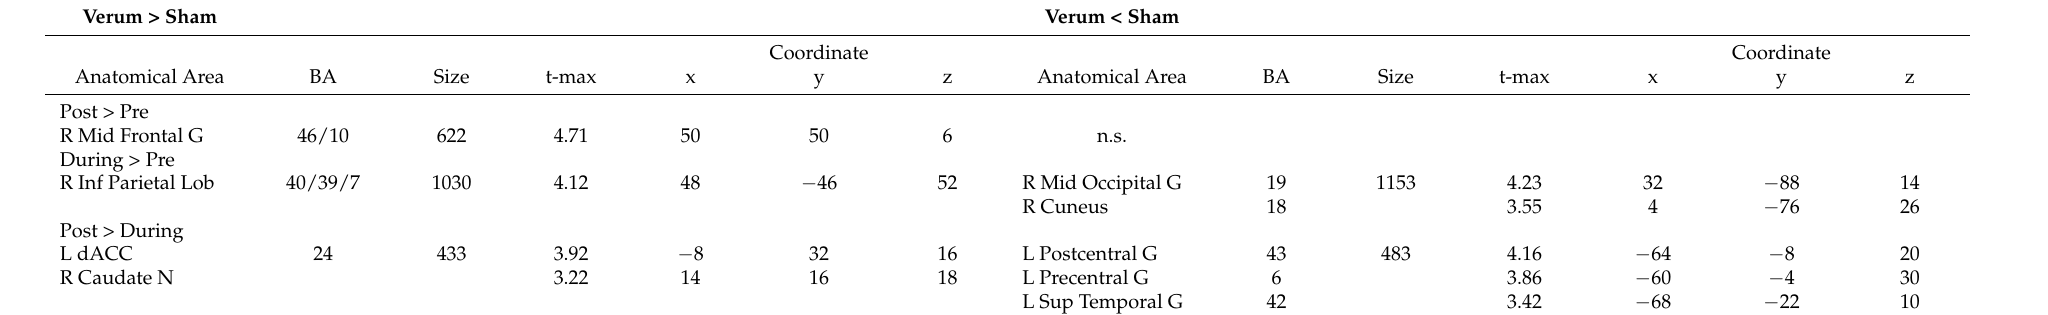
Table 3. Changes in functional connectivity map between verum and sham acupuncture